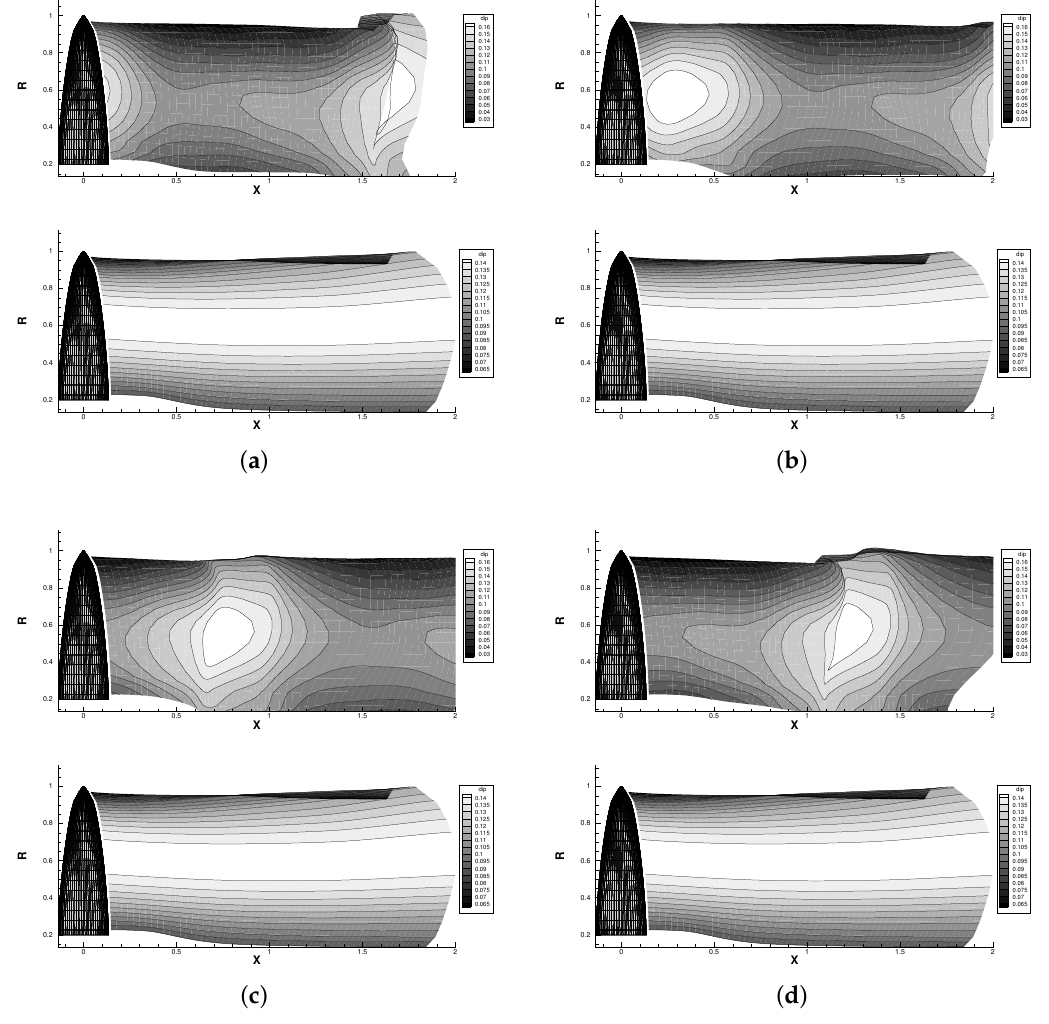
Figure 2. Convection of the wake strength ∆ φ w along the wake surface, plotted on the x – r plane at the blade angle ( a ) θ = 0 ◦ , ( b ) θ = 90 ◦ , ( c ) θ = 180 ◦ , and ( d ) θ = 270 ◦ . Nonuniform wake field is assumed in the upper figure of every pair, and uniform inflow in the lower figure. Only the key blade and its wake are